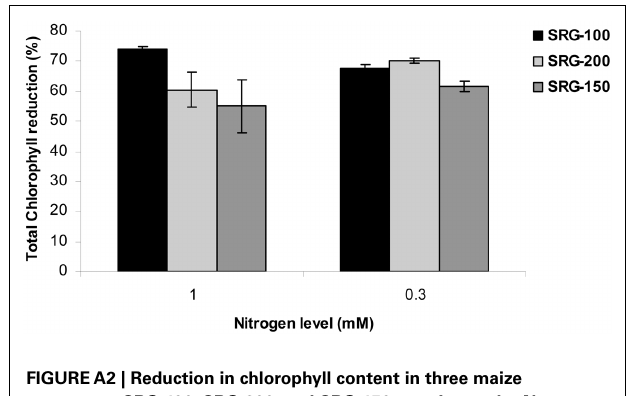
FIGUREA2 | Reduction in chlorophyll content in three maize genotypes, SRG-100, SRG-200, and SRG-150 growing under N limitation.Values are relative to the same genotypes growing at sufficient N